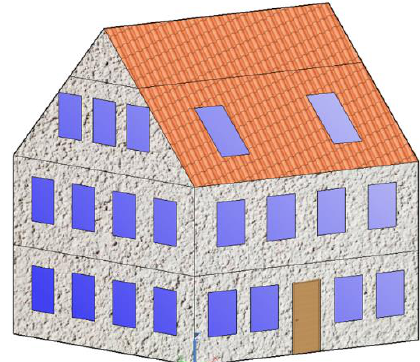
Figure 2. Schematic depiction of residential building modeled in Energy Plus.